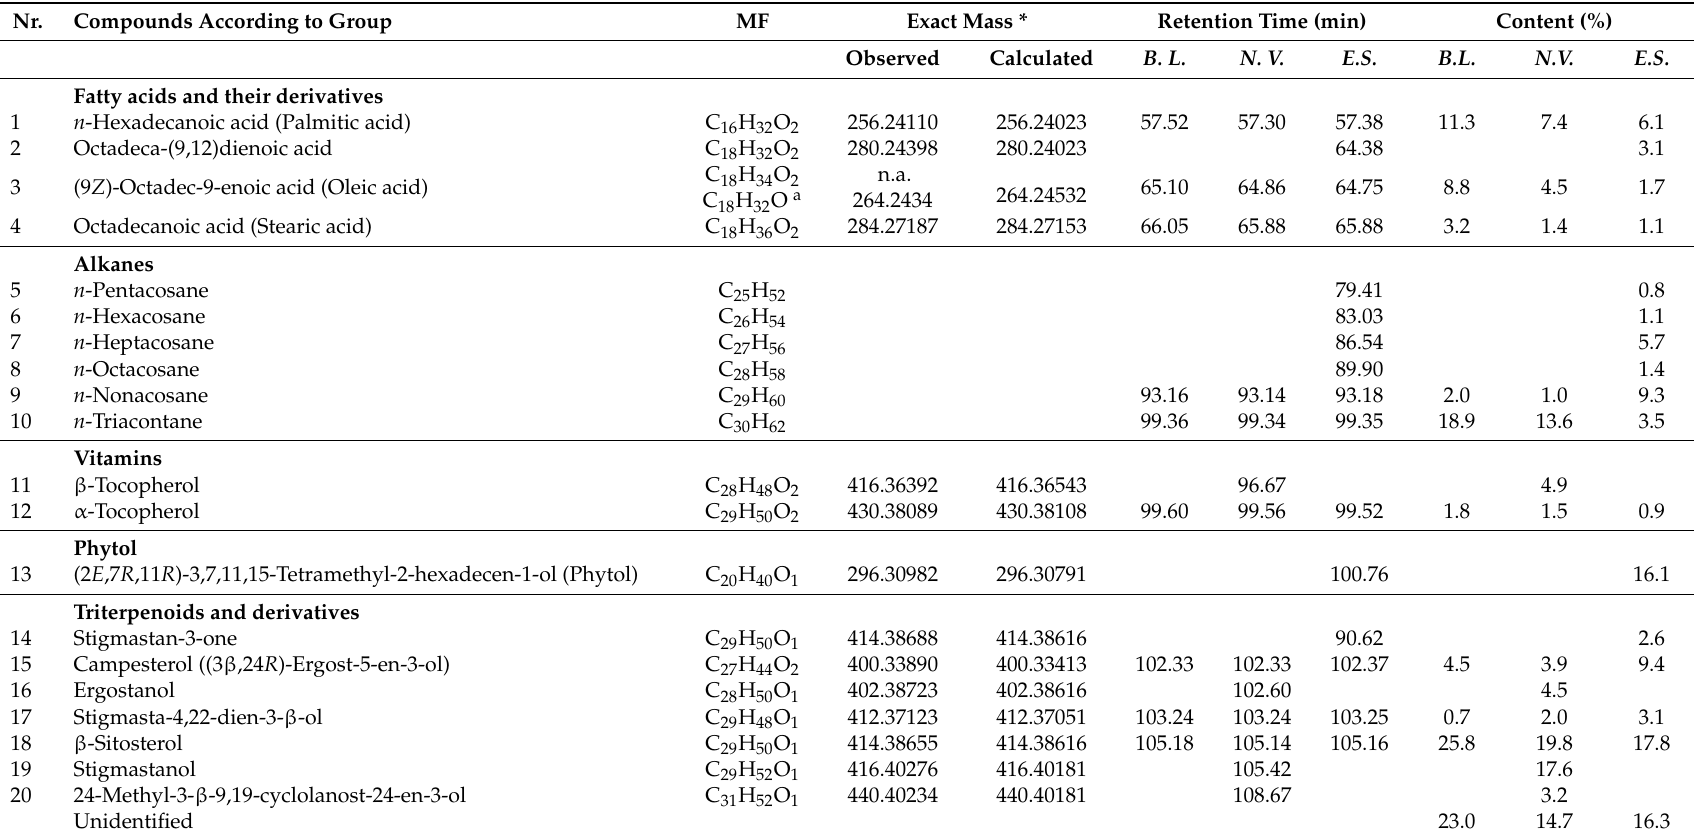
Table 1. Compounds identified from hexane extracts of leaves of B. laciniosa , N. variegata and E. spectabile